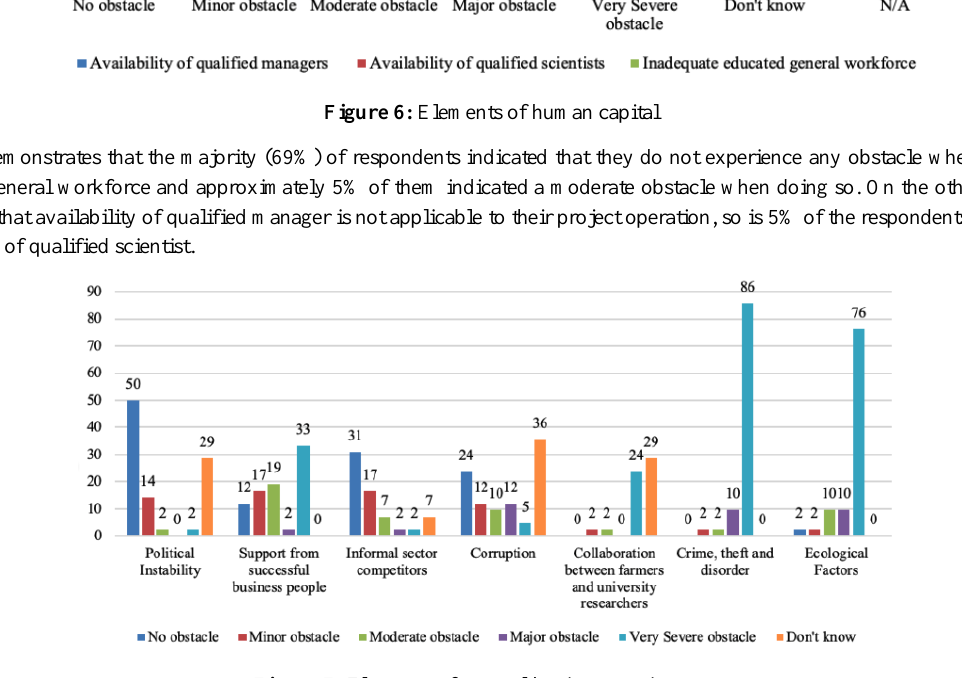
Figure 7: Elements of general business